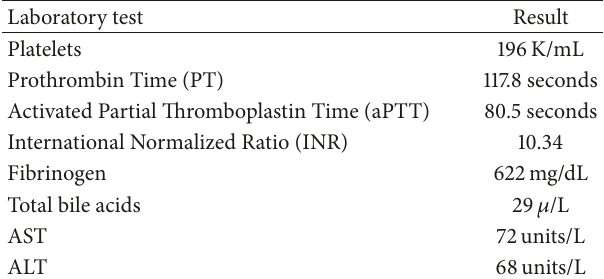
Table 1: Laboratory values at initial